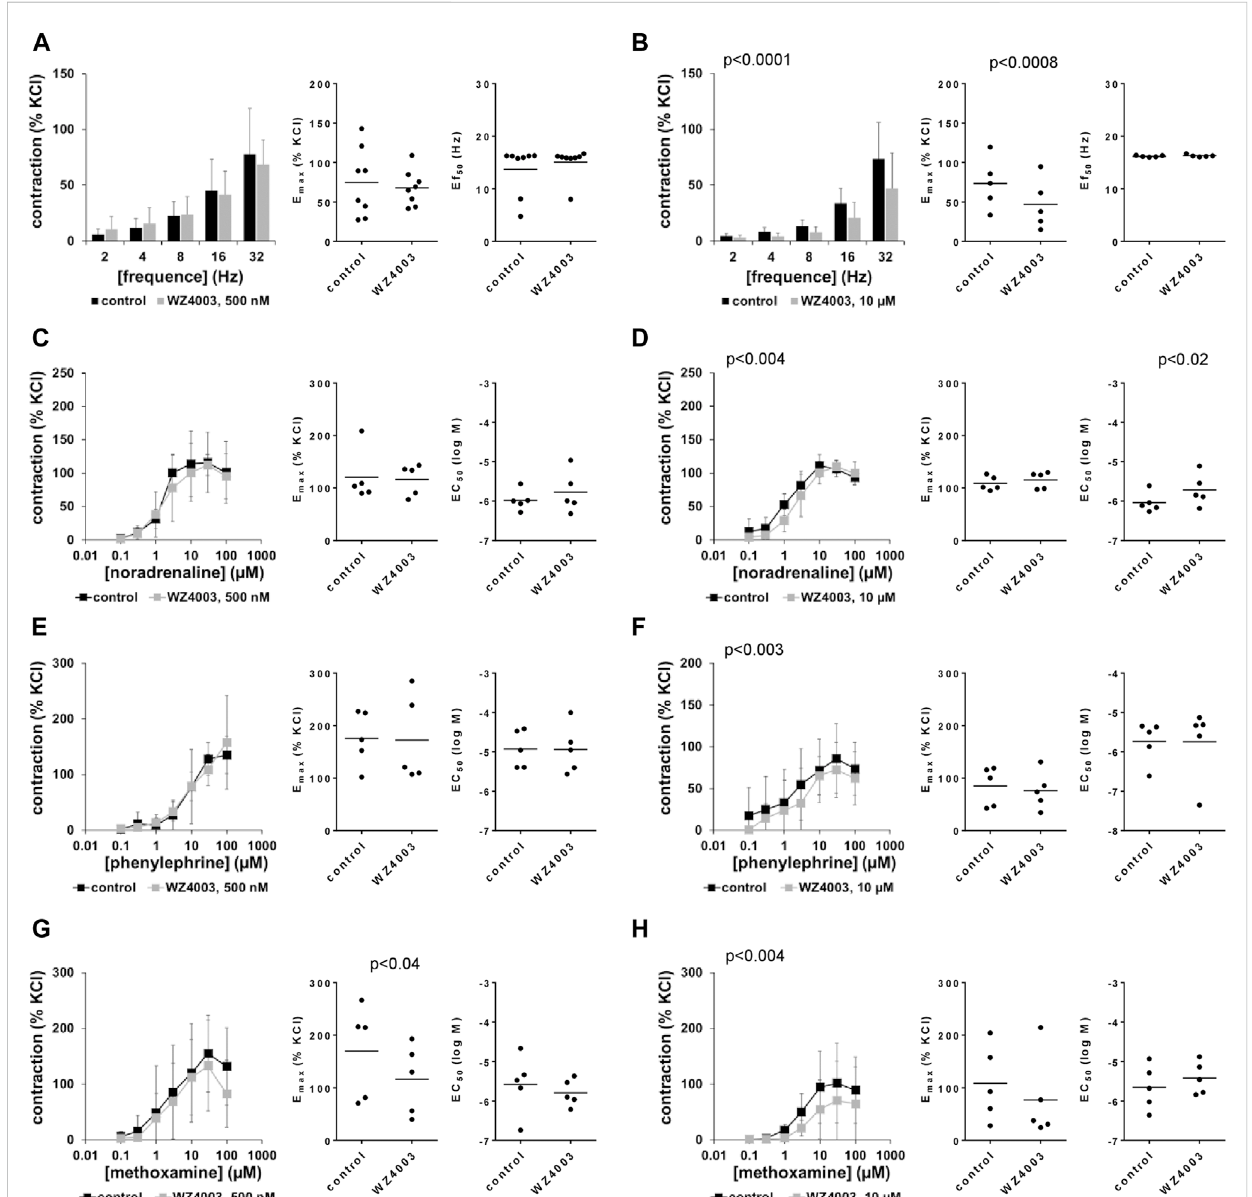
FIGURE 10 Effects WZ4003 on EFS-induced and adrenergic contractions of human prostate tissues. Contractions of human prostate tissues were induced by EFS (A,B) ,noradrenaline (C,D) ,phenylephrine (E,F) ormethoxamine (G,H) inanorganbath,30 minafteradditionofWZ4003inconcentrationsof500 nM (A,C,E,G) or 10 µM (B,D,F,H) or of an equivalent amount of DMSO (controls), which was used as solvent for WZ4003. Shown are data from n = 8 independent experiments in (A) and n = 5 independent experiments in each other subpanel, where tissues from n = 8 or n = 5 patients were used for both groups of a subpanel, resulting in paired samples. Shown are means ± SD from all experiments in concentration response curves with p values from two-way ANOVA for whole groups, and all single E max , EC 50 and Ef 50 values from all experiments (calculated by curve fi tting) together with p values from Student ’ s t -test in scatter